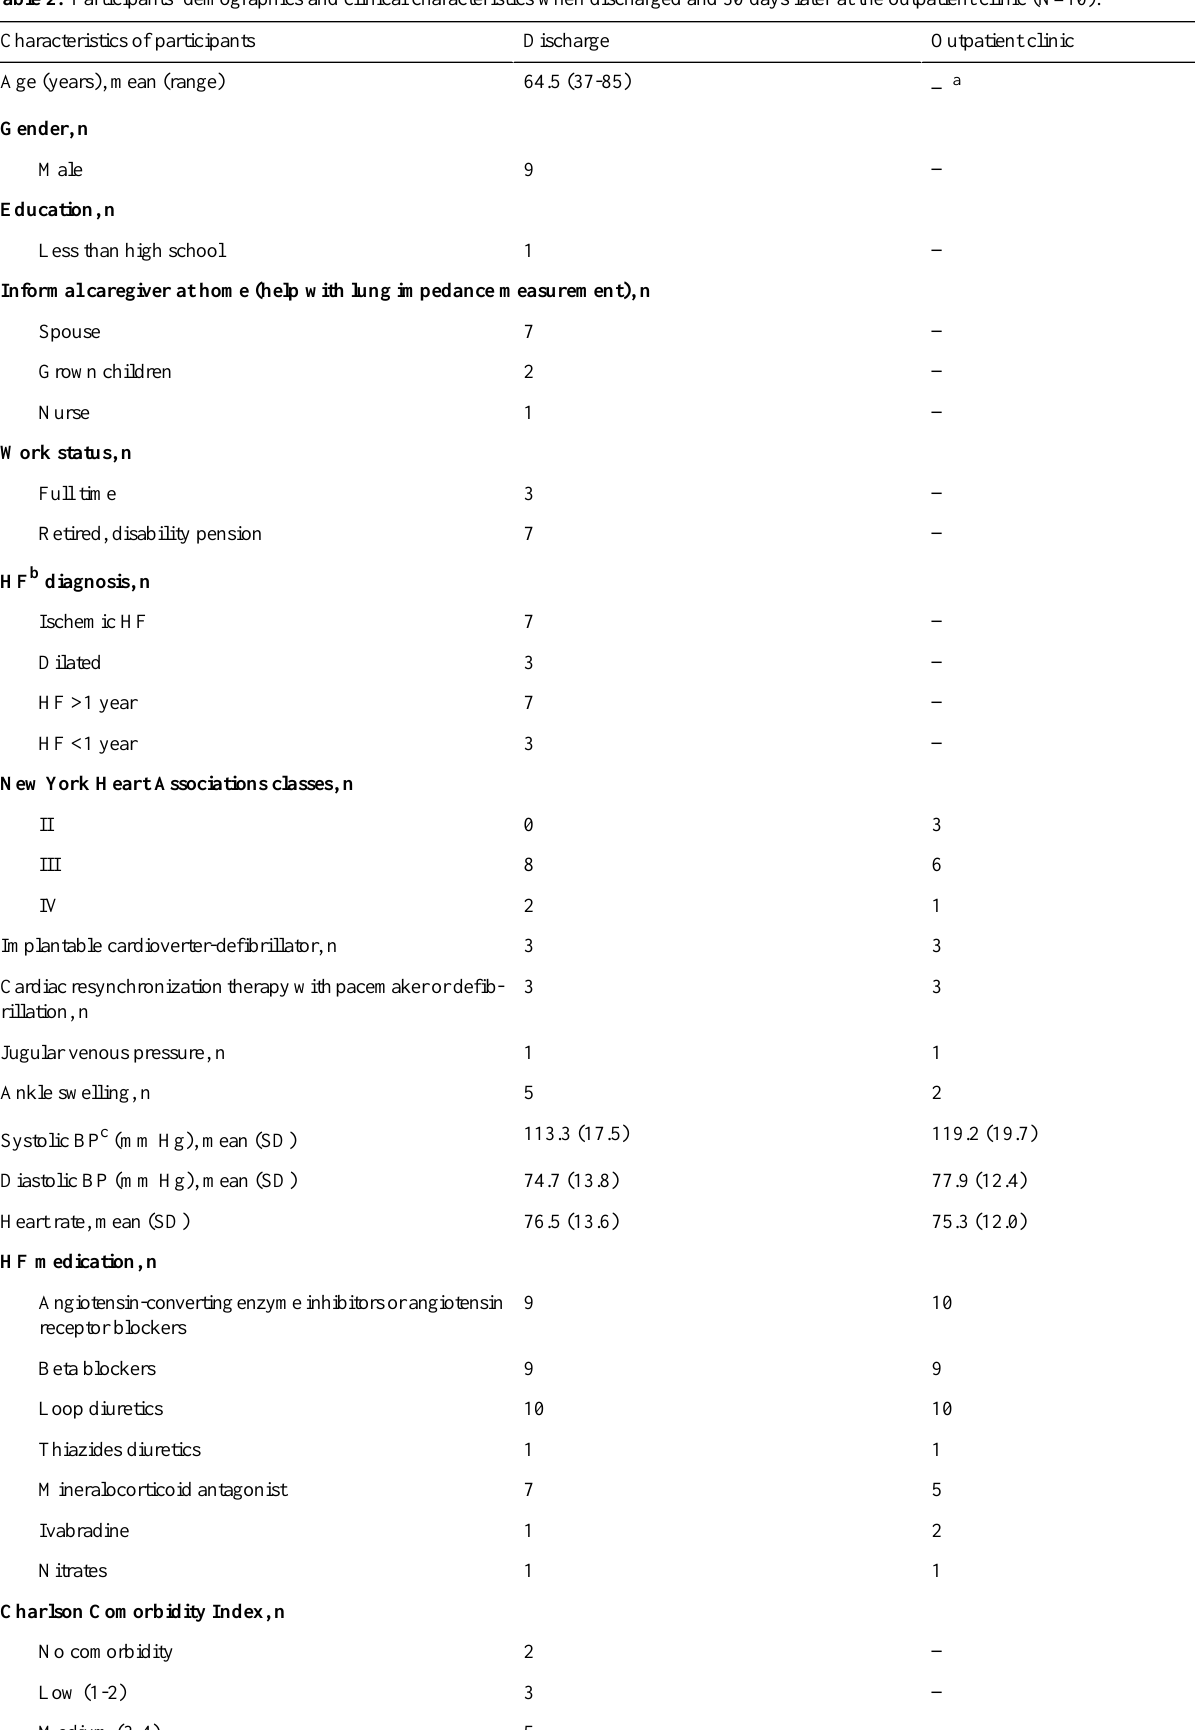
Table 2. Participants’demographics and clinical characteristics when discharged and 30 days later at the outpatient clinic (N=10).